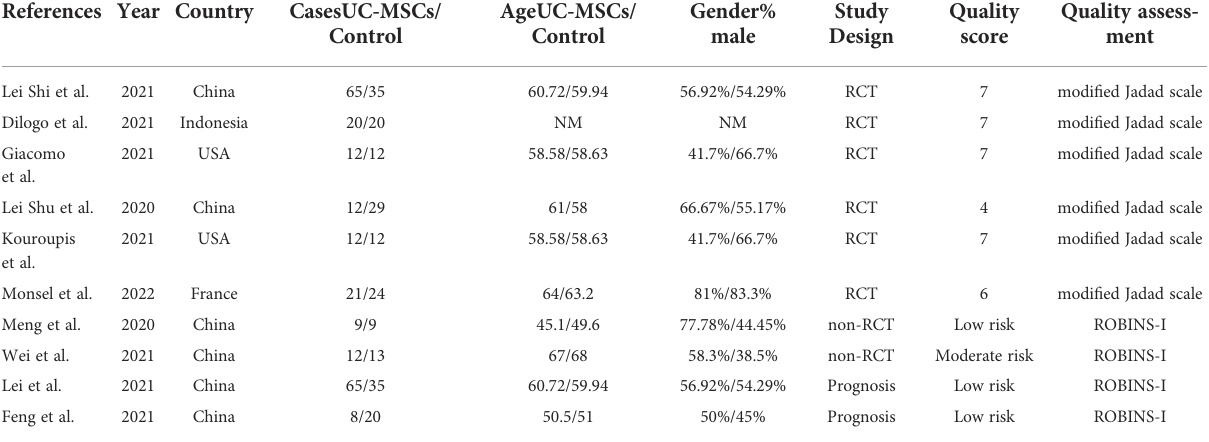
TABLE 2 Characteristics of included